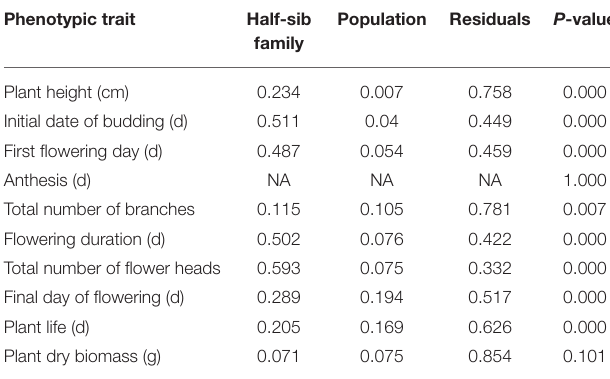
TABLE 2 | Variation among half-sib families within population (i.e., variance partitioning) for each trait. Phenotypic